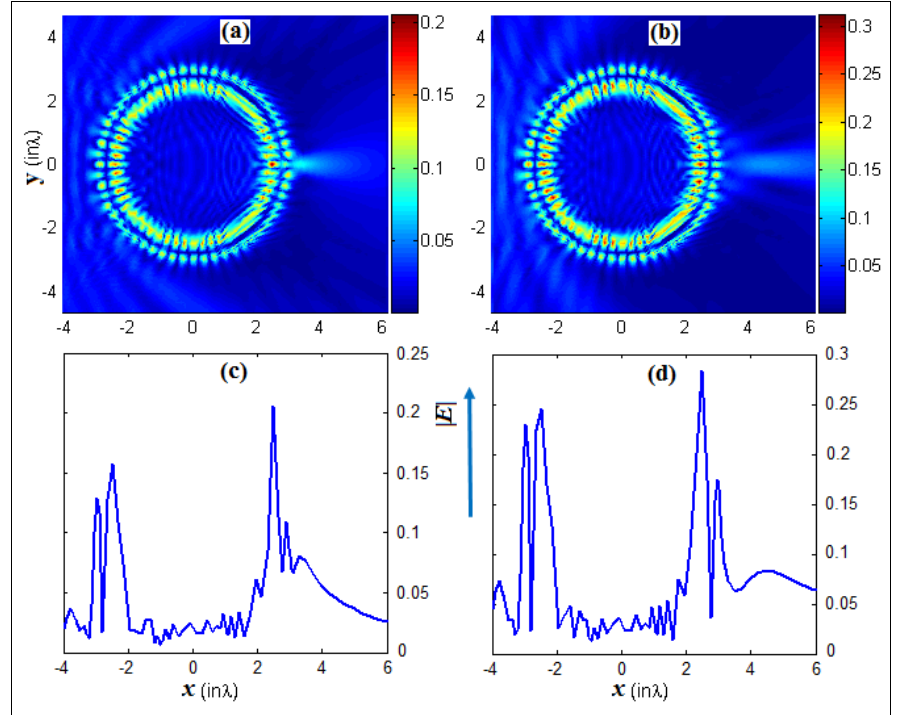
Figure 4. Illumination by a point-source placed at two positions: ( a ) d = 10 λ , ( b ) d = 5 λ , when R = 3.06267 λ , n = 1.95. The associated field magnitudes along x-axis are shown in ( c ) and ( d ), respectively. (The colormap denotes the total field